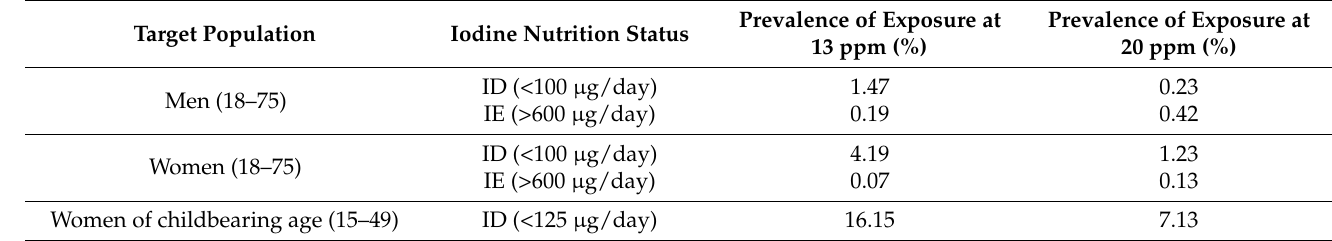
Table 4. Prevalence of men and women (age 18–75) with an estimated iodine intake below 100 µ g/day, defined as iodine deficiency (ID), or >600 µ g/day, defined as iodine excess (IE), as well as the prevalence of women of childbearing age (age 15–49) with an insufficient intake (<125 µ g/day) at 13 and 20 ppm fortification levels.